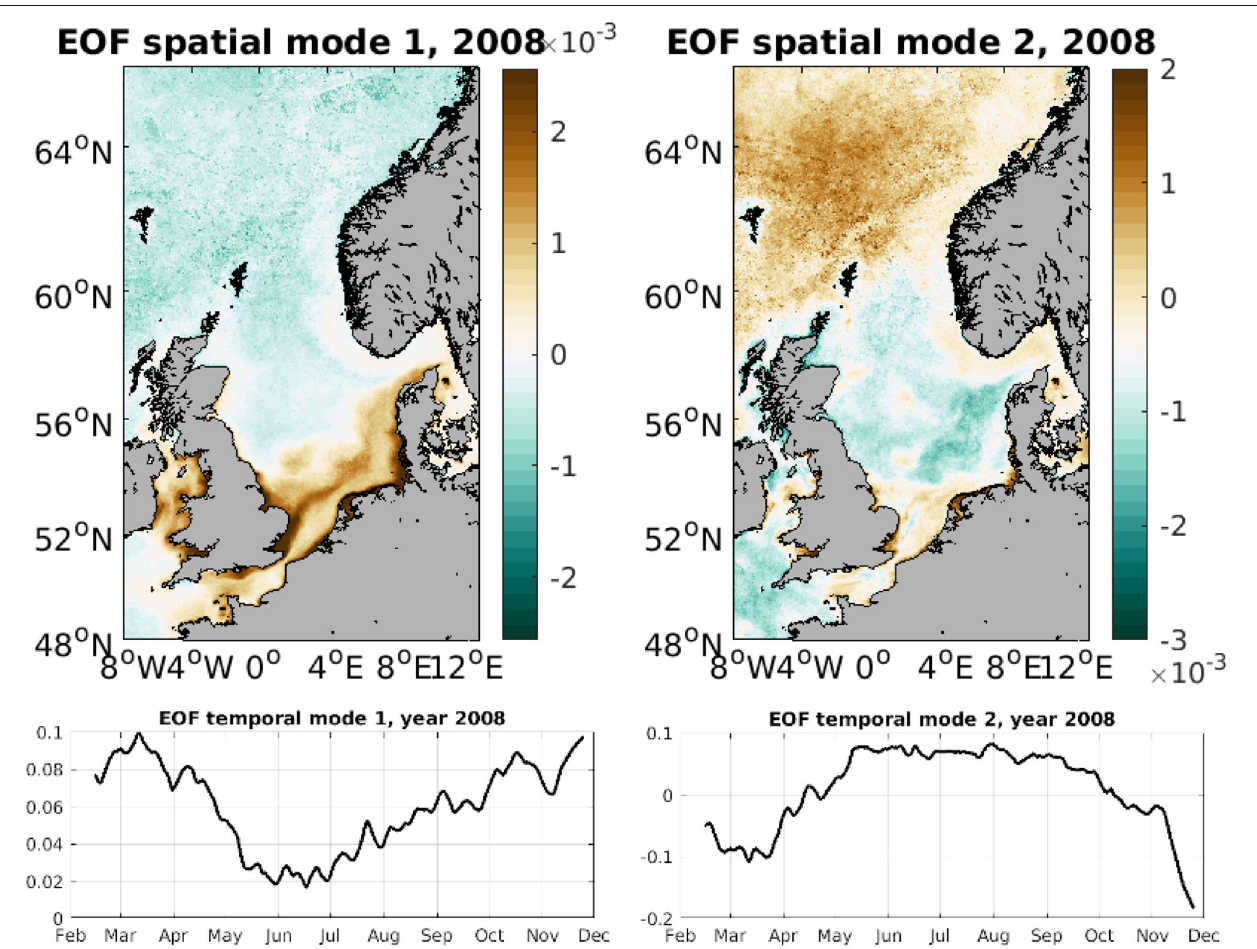
FIGURE 7 | First two spatial SPM EOF modes for 2008 (top) and first two temporal SPM EOF modes for 2008 (bottom)